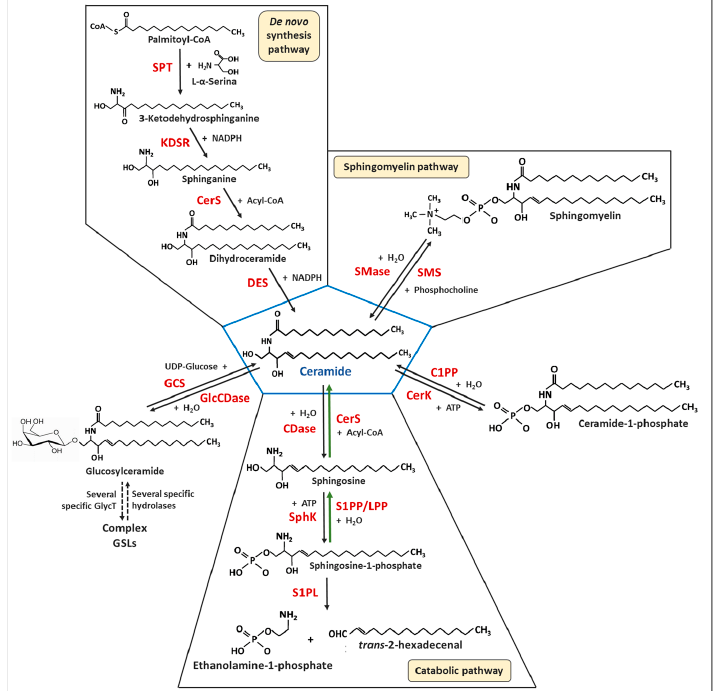
Figure 1. Metabolic pathways of sphingolipids. Abbreviations: CDases, ceramidases; CerK, ceramide kinase; CerS, (dihydro)ceramide synthase; C1PP, ceramide-1-phosphate phosphatase; DES, dihydroceramide desaturase; GCS, glucosylceramide synthase; GlcCDase, glucosylceramidase; GSLs, glycosphingolipids; KDSR, 3-ketosphinganine reductase; LPP, lipid phosphate phosphatases; SMase, sphingomyelinase; SMS, sphingomyelin synthase; SphK, sphingosine kinase; S1PL, sphingosine-1-phosphate lyase; S1PP, sphingosine 1-phosphate phosphatase; SPT, L-serine palmitoyltransferase. Green arrows indicate the salvage pathway.